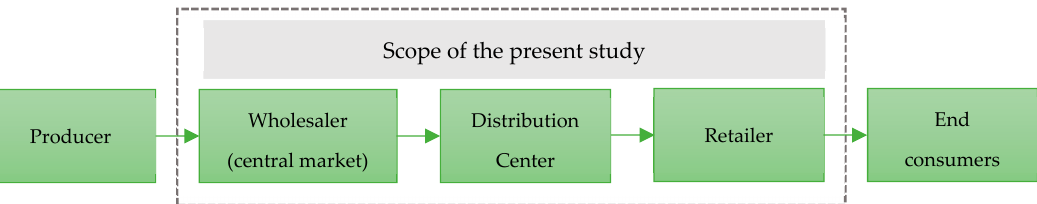
Figure 2. Fresh products logistics.